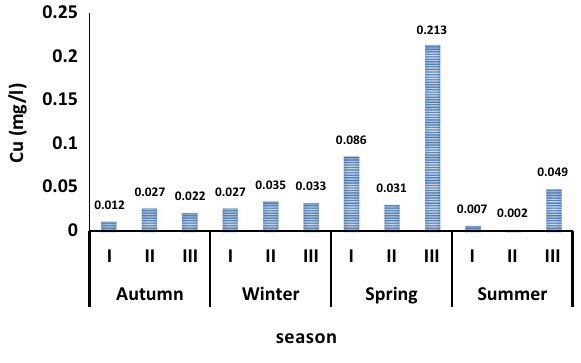
Fig. 5 Cu concentration (mg/L) in water samples from autumn 2018 to summer 2019 along the investigated area